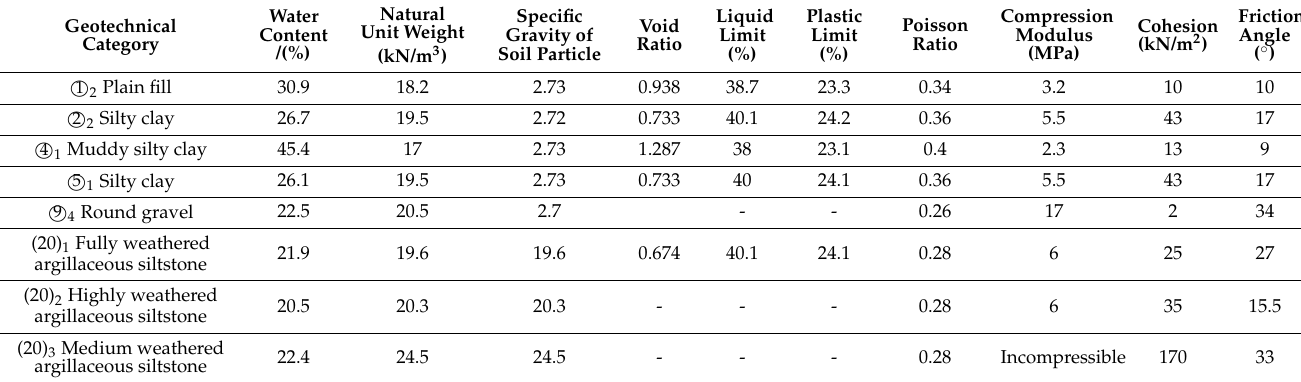
Figure 2. Longitudinal geological profile of the interval tunnel. Table 1. Soil parameters.